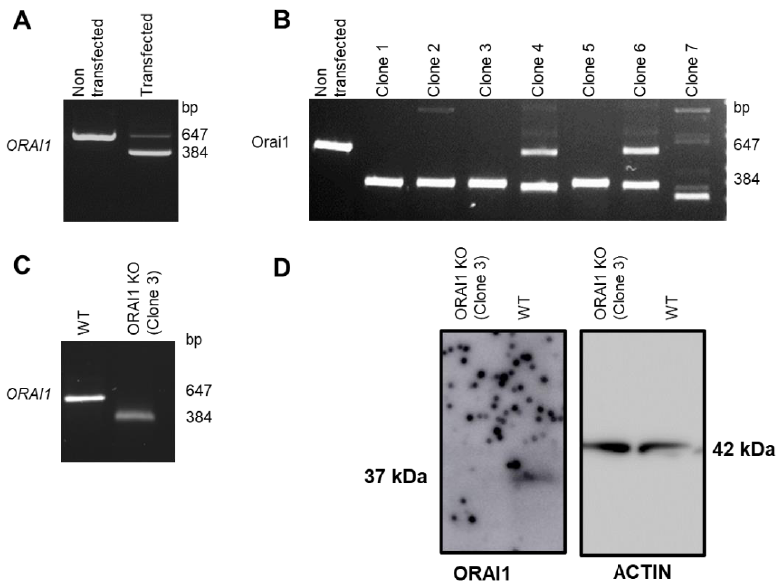
Figure 2. Genomic validation of complete ORAI1 knockout (KO) generation. ( A ) Polymerase chain reaction (PCR) performed on genomic DNA (gDNA) of nonclonal cells corresponding to non-transfected cells and cells transfected with two guide RNAs (gRNAs). Cells transfected with two gRNA present a smaller band (384 bp) indicating the existence of recombination events. ( B ) PCR performed on gDNA of single-cell-derived clones. Clones 1, 3, and 5 presenting a single band around the expected size (384 bp) were selected for further experiments. ( C ) PCR performed on gDNA of wild type (WT) and ORAI1 KO HEK-293 cells. The ORAI1 KO clone presents a lower band indicating successful ORAI1 gene deletion. ( D ) Western blot analysis of WT and ORAI1 KO HEK-293 cells. WT cells exhibit an ORAI1 band around 37 kDa, while ORAI1 KO cells lack this band.